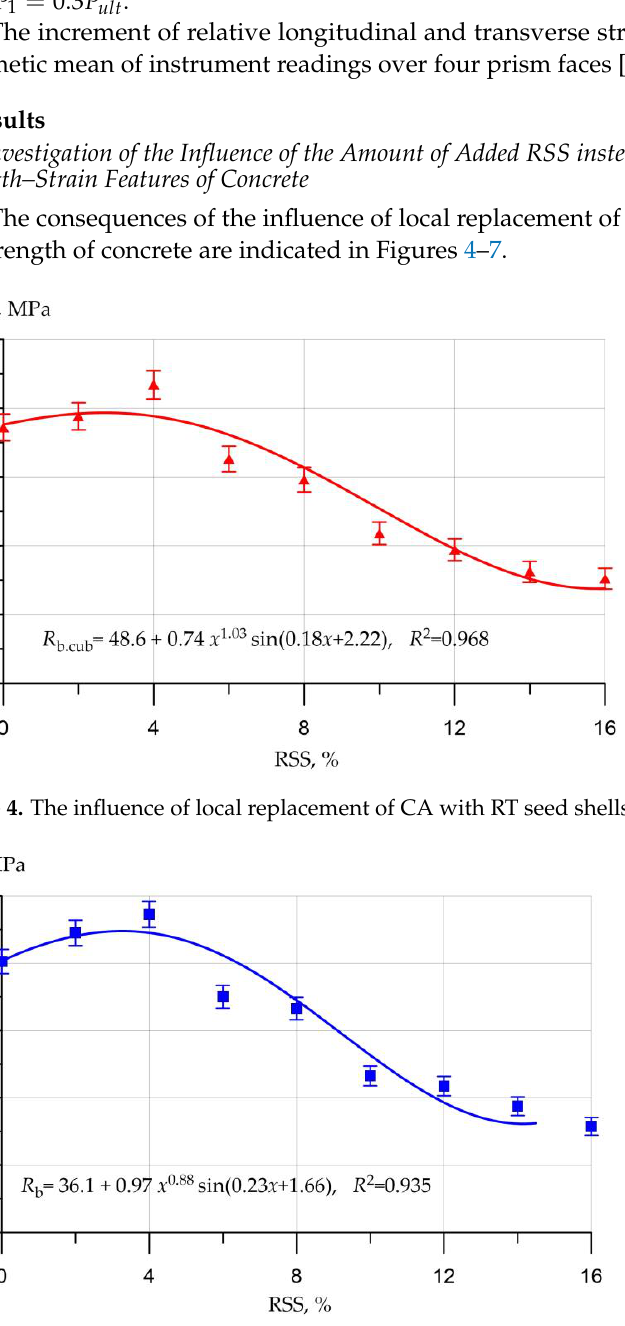
Figure 6. Consequences of investigational studies of the influence of local replacement of CA with RT seed shells on TS in twisting btb R .